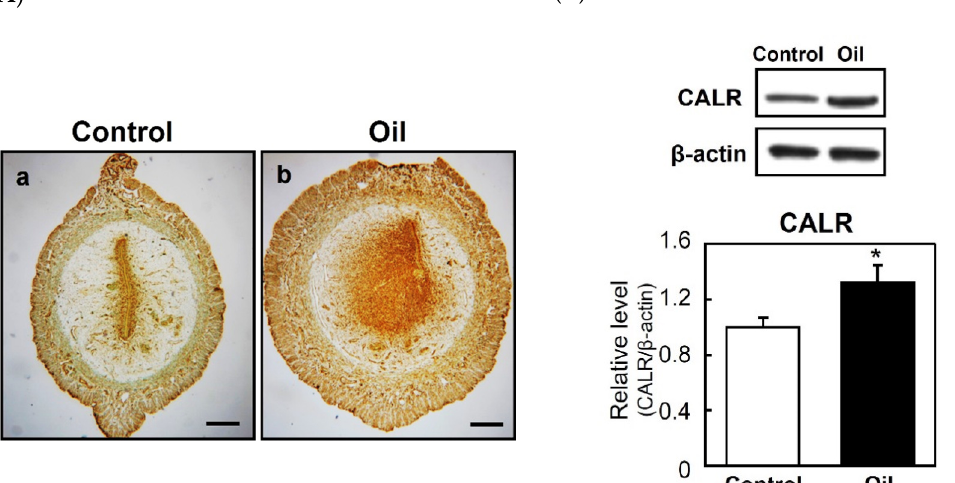
Figure 3. Expression of calreticulin (CALR) in the artificially induced decidua. Female rats were mated with vasectomized males and sesame oil (100 µ L) was infused into the lumen of one uterine horn on day 5 of pseudopregnancy to induce artificial decidualization. The uteri were dissected 48 h after the infusion. Immunostaining of CALR in control ( Aa ) or oil injected horn ( Ab ). Scale bars = 250 μ m. Immunoblot analyses of CALR expression in the uteri of control or those injected with sesame oil ( B ). The graph shows the relative level of CALR normalized to that of β -actin. Data represent the mean ± SEM ( n = 3). * p < 0.05.